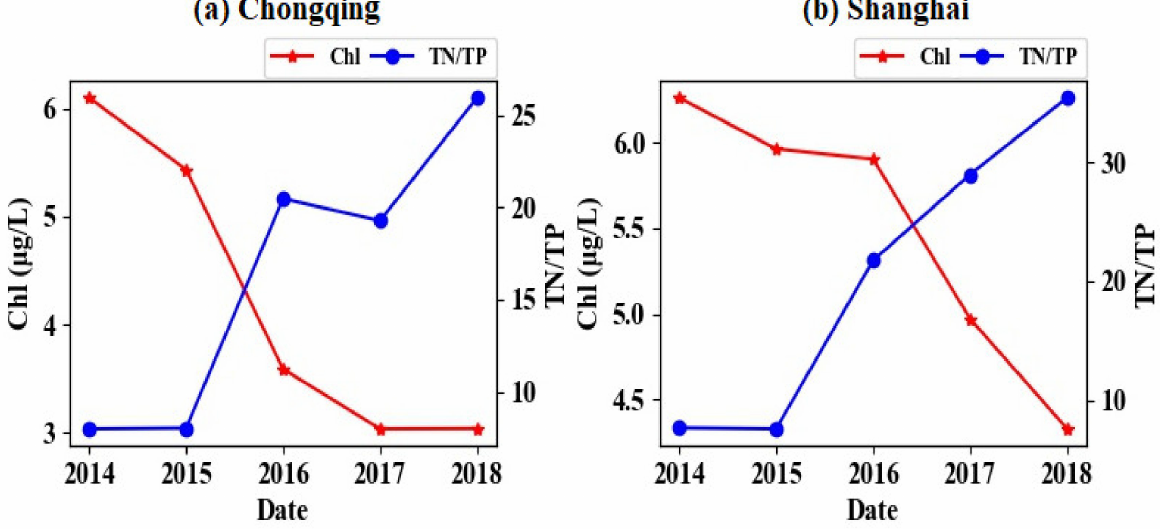
Figure 12. Variations in the ratio of TN and TP in discharged sewage and the Chl-a concentrations in Chongqing and Shanghai from 2014 to